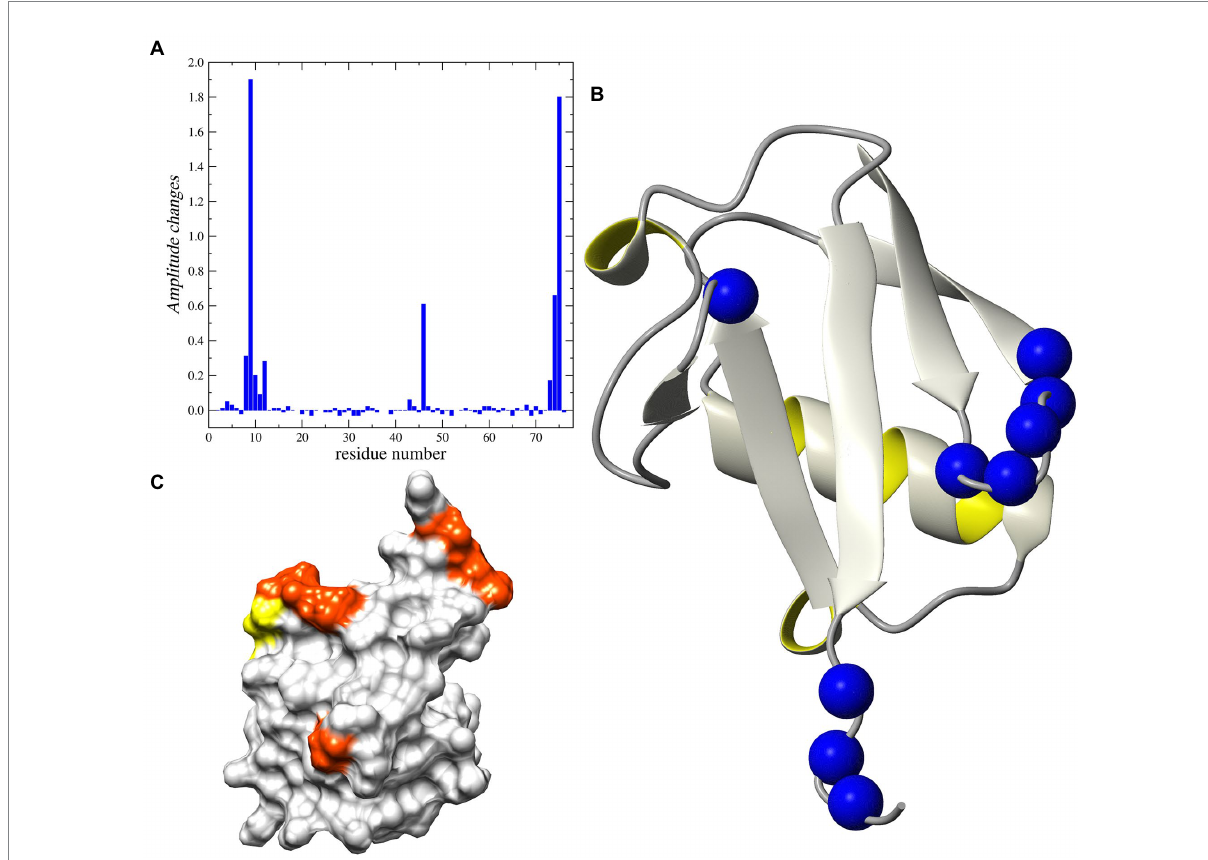
FIGURE 6 NMR analysis of Peptide-12 binding to ubiquitin. (A) Relative changes in intensity of 1 H- 15 N HSQC cross-peaks induced by the addition of the peptide-12. (B) Ribbon representation of the 3D structure of human ubiquitin. The 15 N nuclei in the residues corresponding to the increased peak heights are shown as blue balls. (C) The surface presentation of human ubiquitin. The positions of the residues demonstrating the increased peak intensity are highlighted in orange and